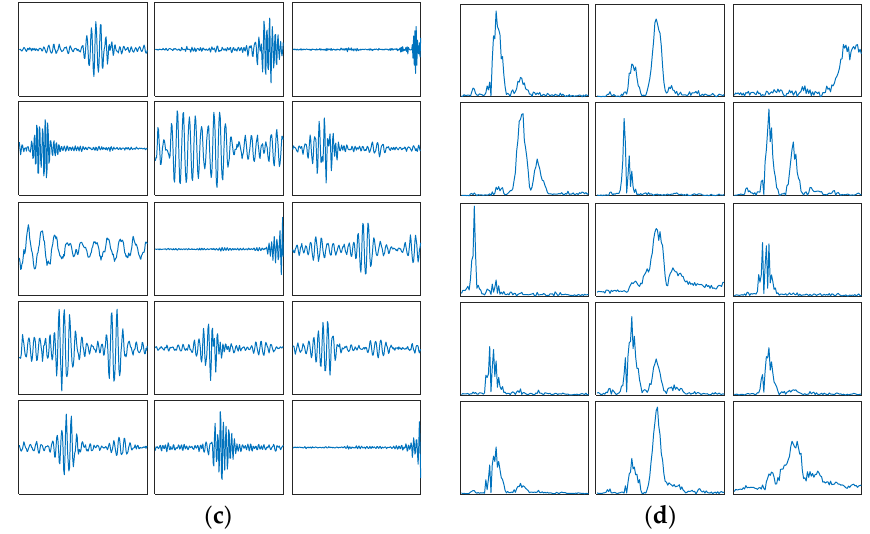
Figure 9. Row vectors of W : ( a ) Vectors of N in = 100 in the time domain; ( b ) Vectors of N in = 100 in the frequency domain; ( c ) Vectors of N in = 200 in the time domain; ( d ) Vectors of N in = 200 in the frequency domain.